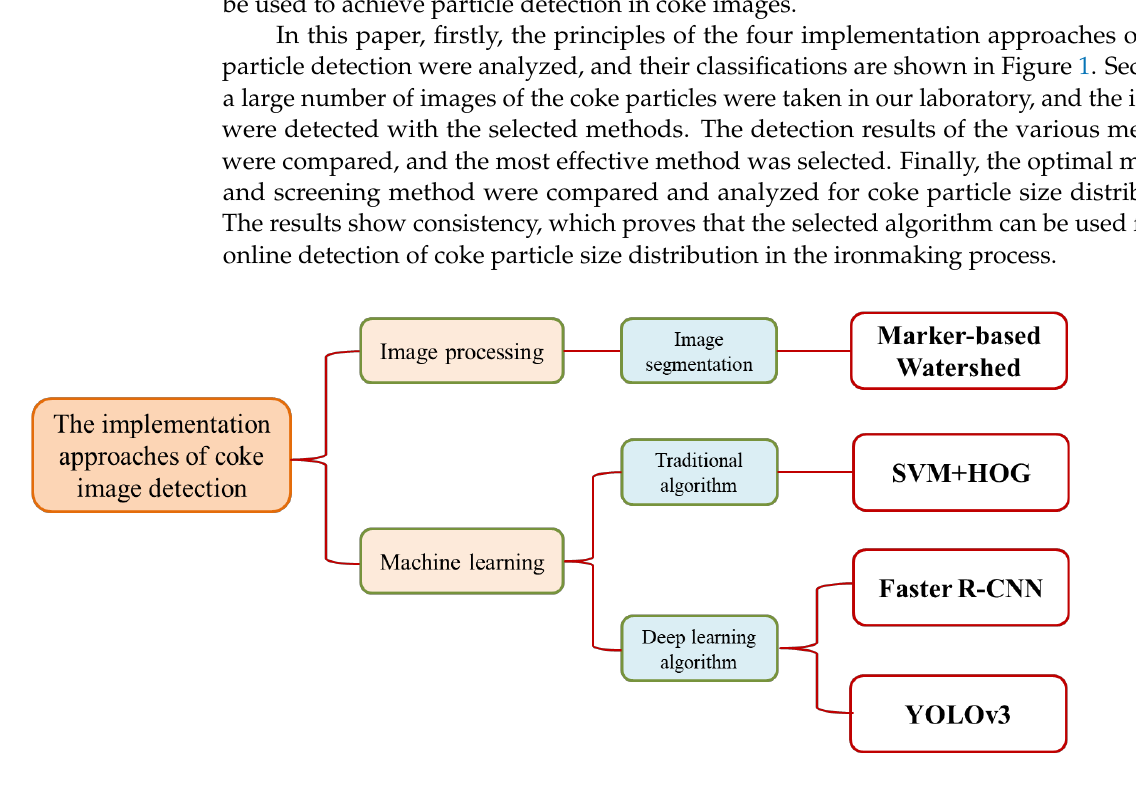
Figure 1. Four approaches for coke particle image detection.